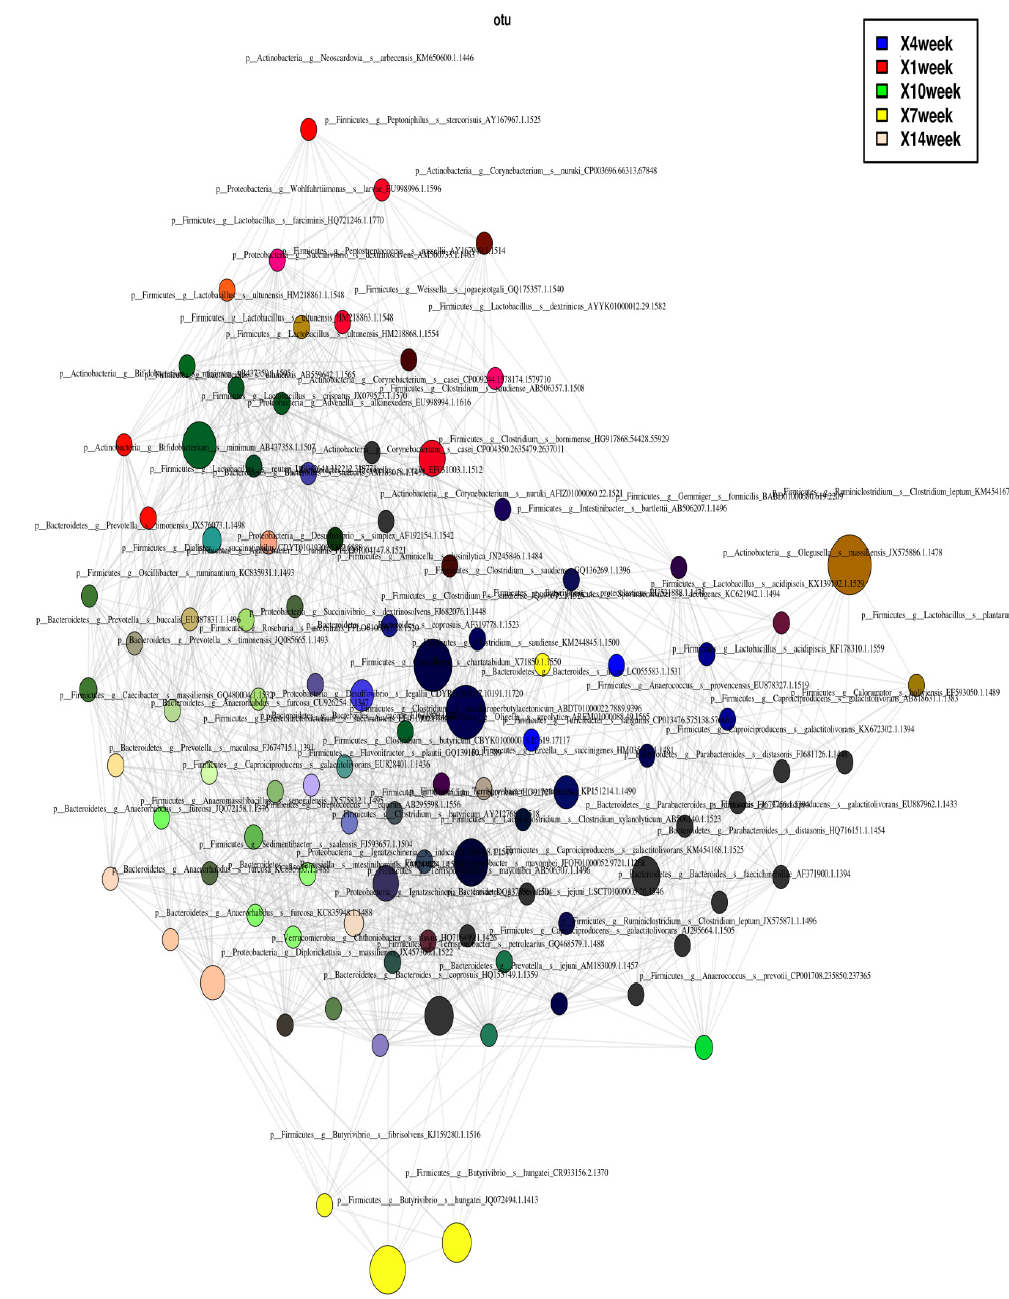
Figure 8. Operational taxonomic unit (OTU) co-occurrence network, where each node indicates the microbial OTU, and the size of the nodes indicates the number of degrees. Different colors indicate the weekly samples.